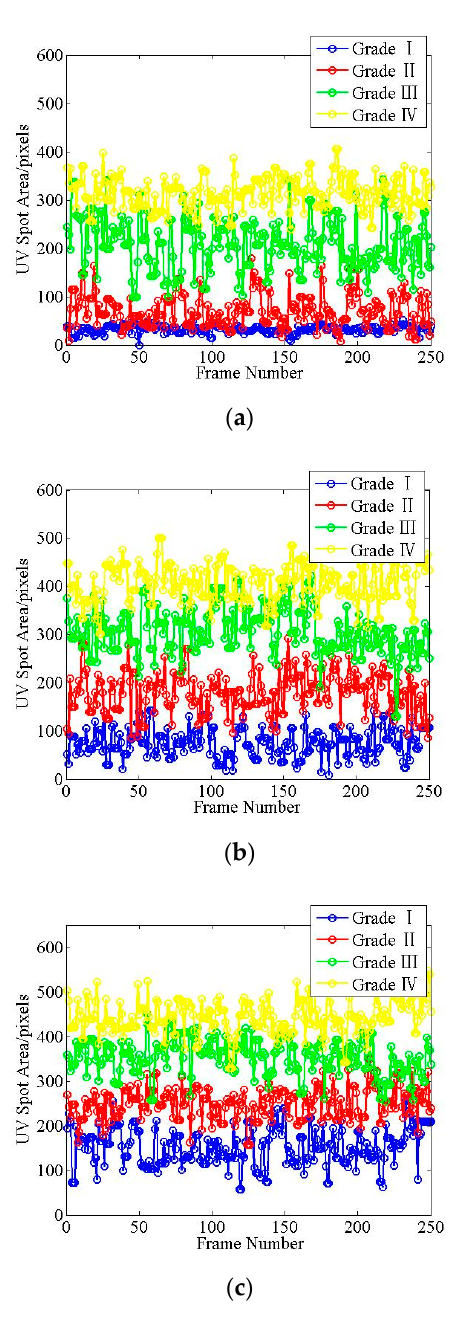
Figure 8. Curves of the spot pixels of UV images: ( a ) in 80% relative humidity, ( b ) in 85% relative humidity, and ( c ) in 90% relative humidity.